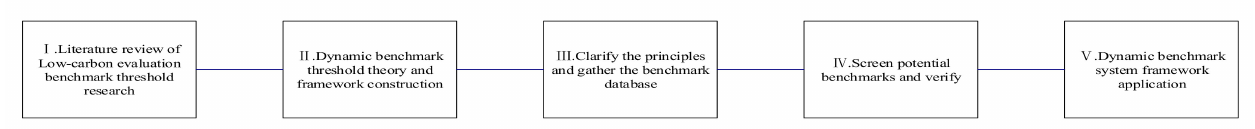
Figure 1. Flow of dynamic benchmark system framework